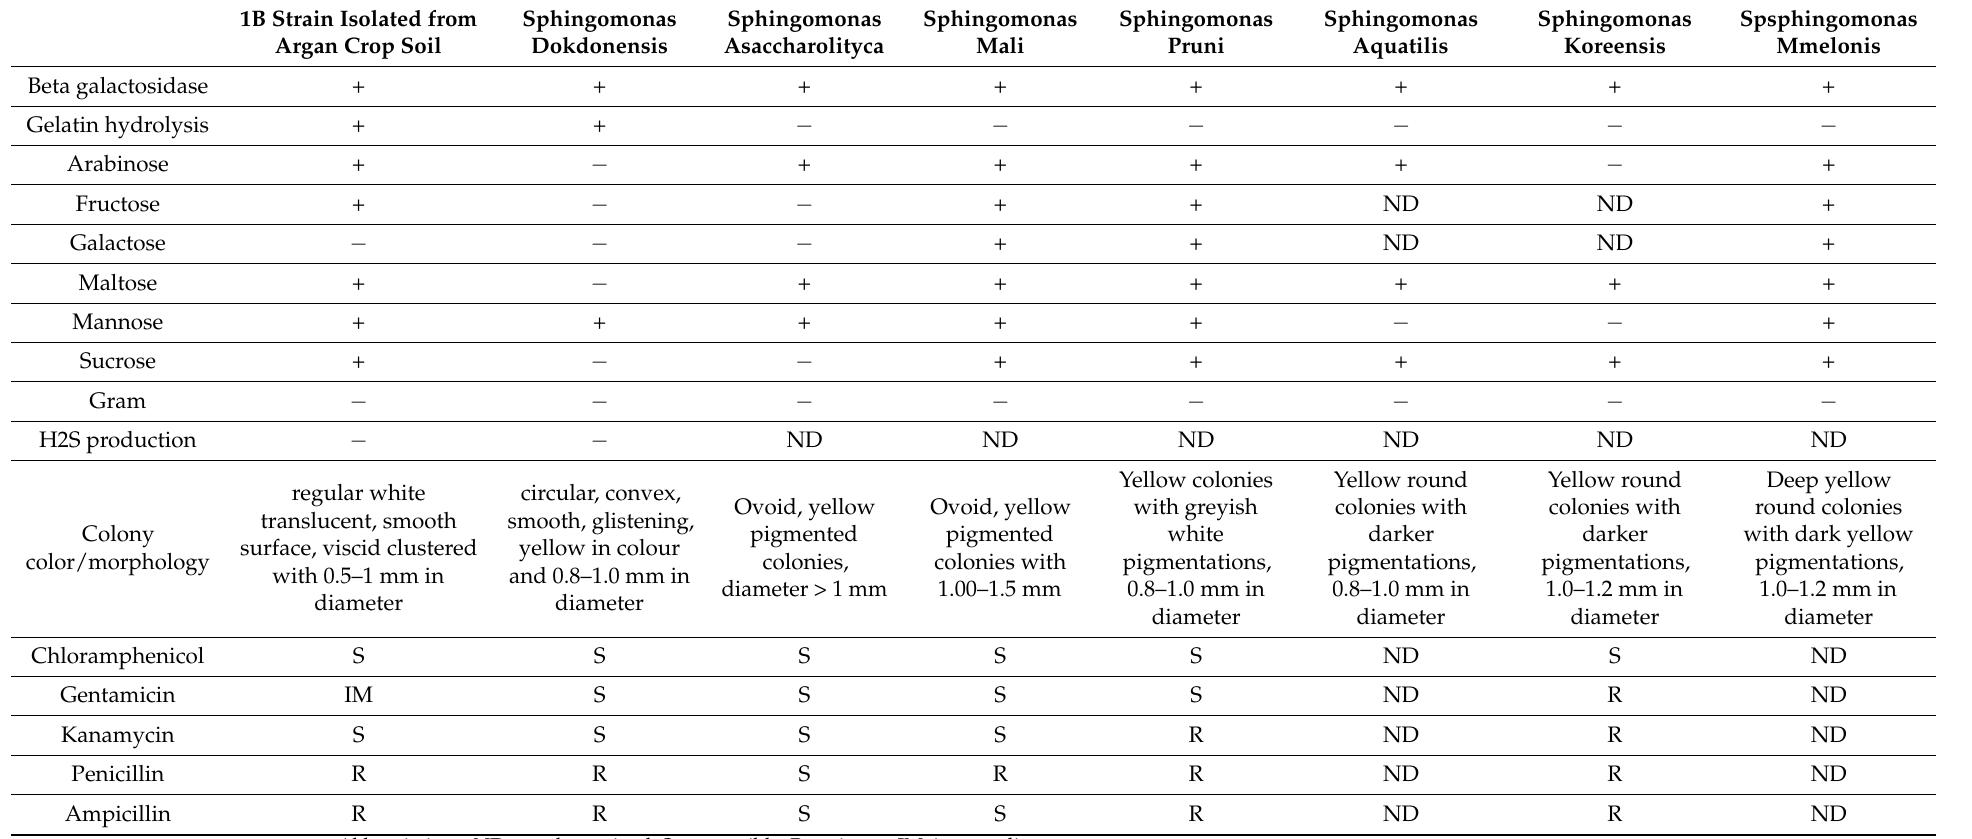
Table 1. Correlation of 1B strain with some Sphingomonas spp. relative to biochemical